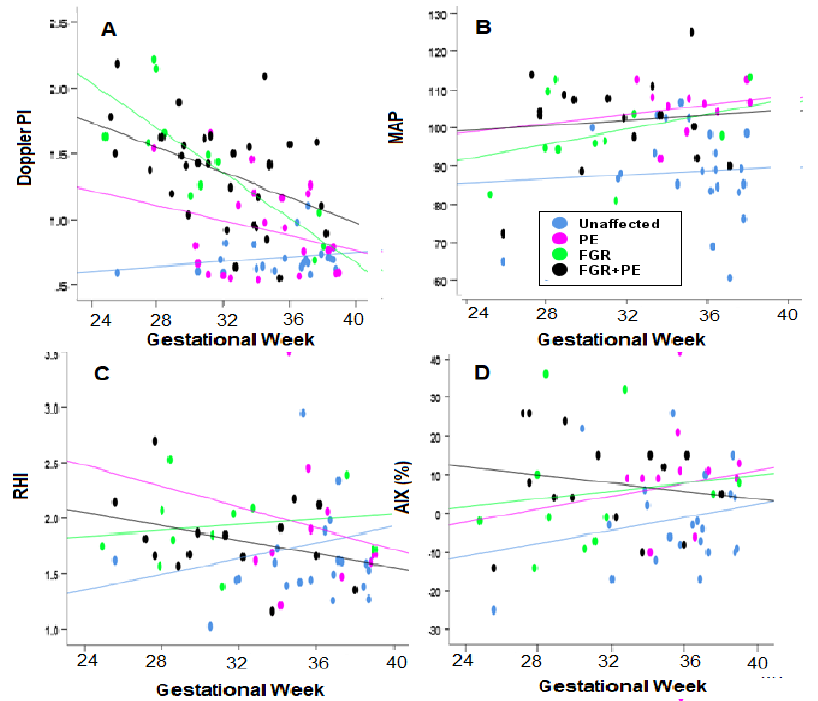
Figure 2. Evaluating the Correlation of Biophysical Markers over Gestational Age . ( A , B ) UtA PI—Uterine artery pulsatility index (Doppler PI in the figure) and MAP; ( C , D ) RHI and AIX. Blue—unaffected group, purple—PE, green—FGR, and black—PE + FGR.